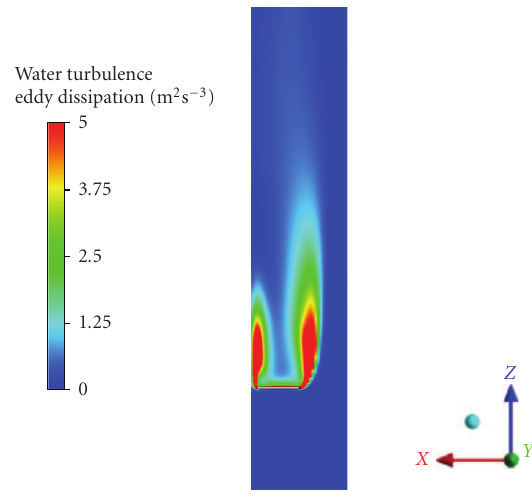
Figure 6: Turbulence eddy dissipation (run 096)